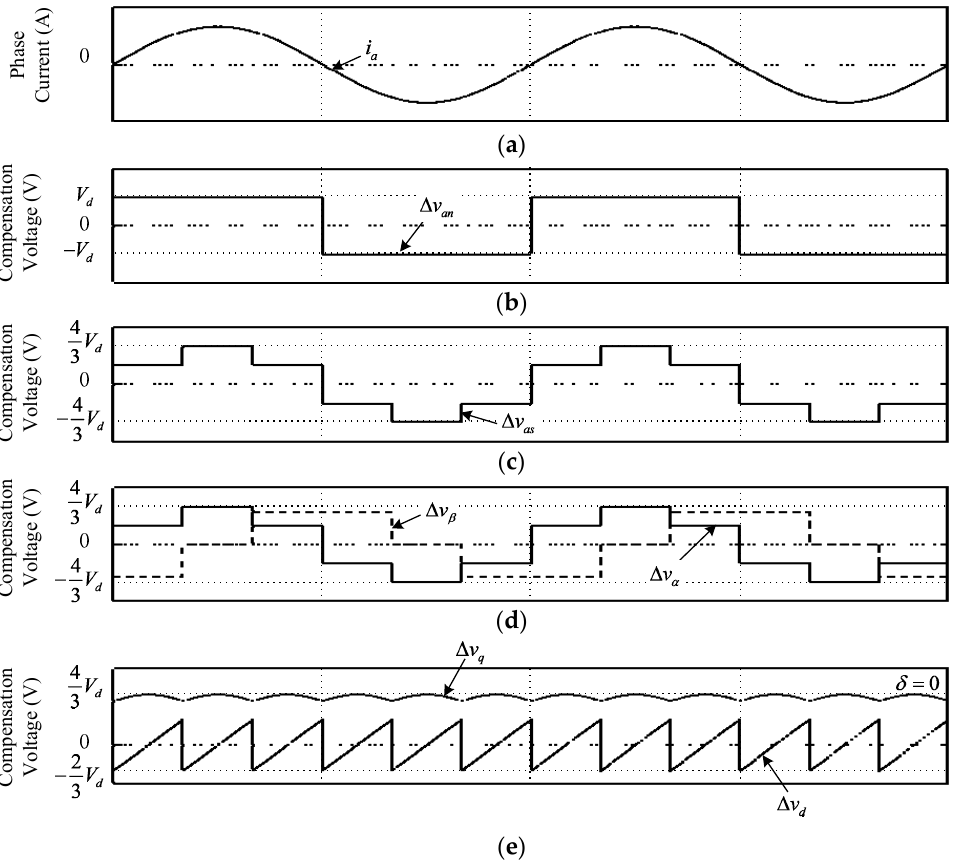
Figure 4. Dead-time compensation voltage waveforms; ( a ) a-phase current; ( b ) average compensation pole voltage (ACPV) of a-phase; ( c ) the average compensation phase voltage of a-phase; ( d ) dead-time compensation voltages on stationary reference frame α − β axis; ( e ) dead-time compensation voltages on the synchronous reference frame d − q axis.